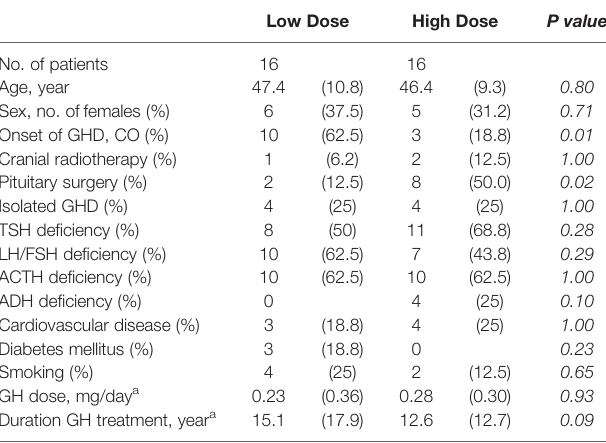
TABLE 1 | Baseline characteristics of the low dose group in which the IGF-1 target level was between − 2 and − 1 standard deviation score (SDS), and the high dose group in which the IGF-1 target level was between 1 and 2 SDS.